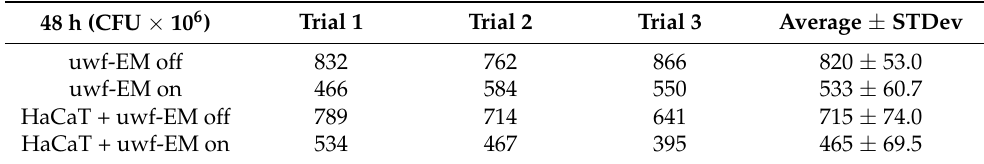
Figure 1. CFUs conducted on M. furfur in three replicates after 48 h of incubation ( a ) with ( right pane ) and without ( left pane ) uwf-EM pre-treatment. ( b ) Quantitative representation of CFU-counts of M. furfur. Colour codes: gray, without uwf-EM stimulation, red with uwf-EM stimulation. Both the calculated effect sizes (d) and p -values ( p < 0.05) underline the statistical significance of the results. Table 1. CFU counts of M. furfur following 48 h of incubation. Both emf-EM-exposed cultures (those in contact with and without HaCaT cells) show a 35% reduction in CFUs compared to non-uwf-EM- exposed controls.